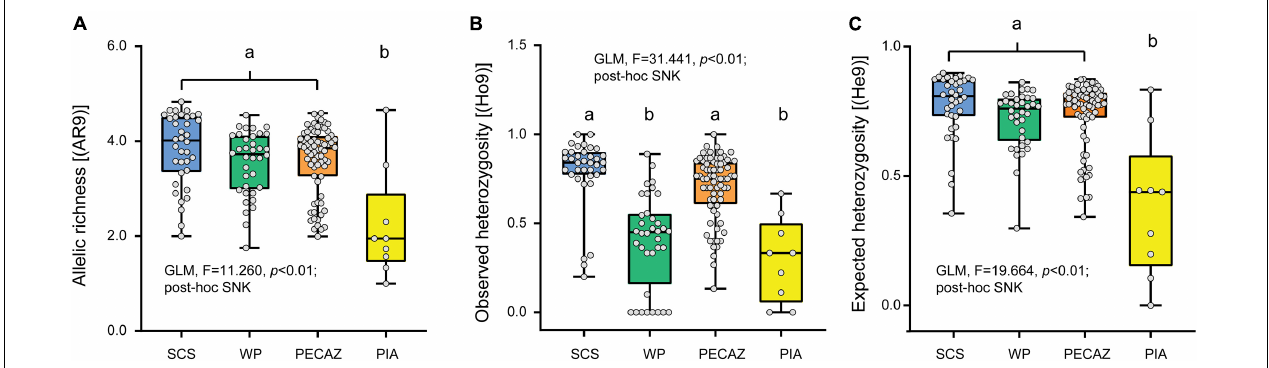
FIGURE 3 | Genetic diversity of crown-of-thorns starfish (COTS) populations in the Pacific Ocean. (A) Allelic richness [AR(9)], (B) observed heterozygosity [Ho(9)], and (C) expected heterozygosity [He(9)] rarefied to a sample size of four regions and 9 genes per regions. SCS mean South China Sea, WP mean Western Pacific, PECAZ mean Pacific equatorial currents affected zone and PIA mean Pacific insular atoll. Genetic diversity differences across regions were analyzed by General Linear Model (GLM) analysis, and post hoc multiple comparisons of significant GLM results were conducted by Student-Newman-Keuls (SNK) test. Lowercase letters indicate post hoc comparisons (SNK) (e.g., a, b) with the significant factors among